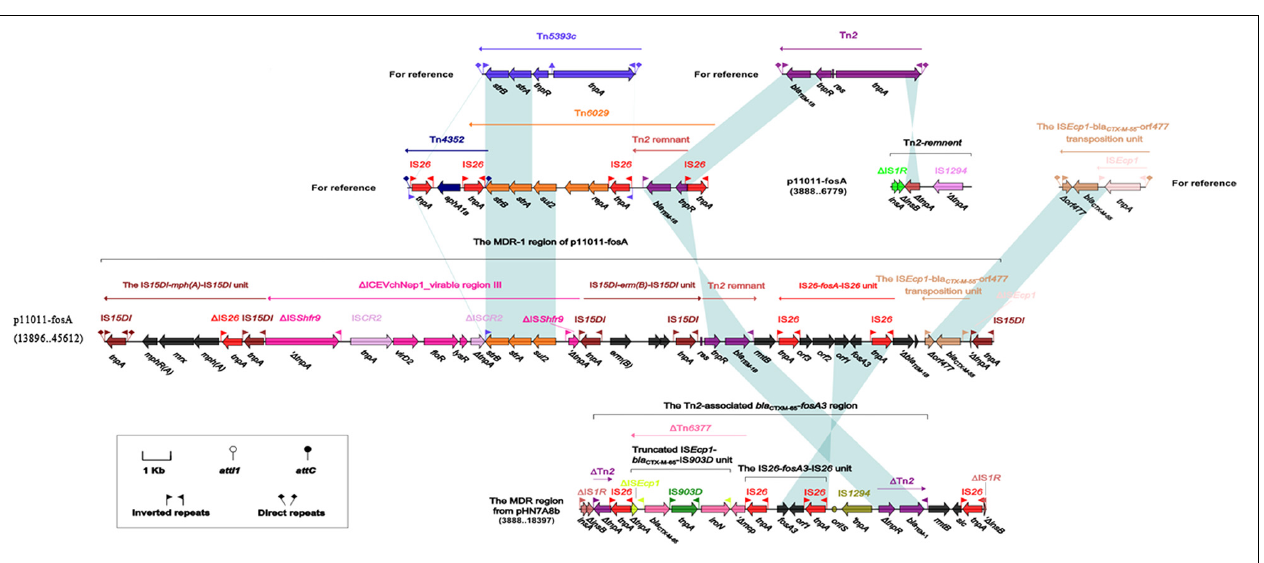
resistance gene bla CTX − M − 55 ), and aacC2 - tmrB